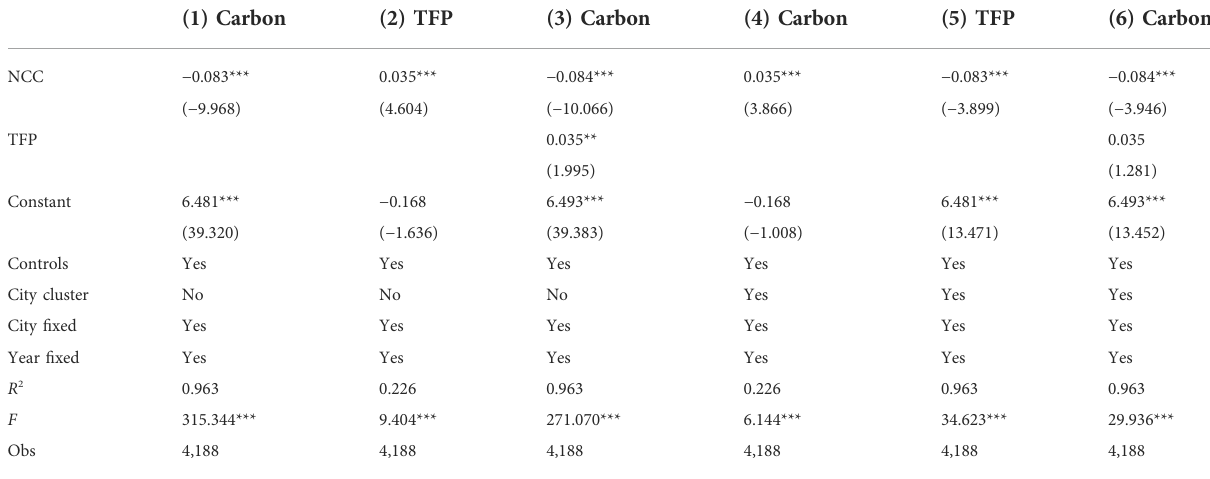
TABLE 7 Mechanism analysis based on